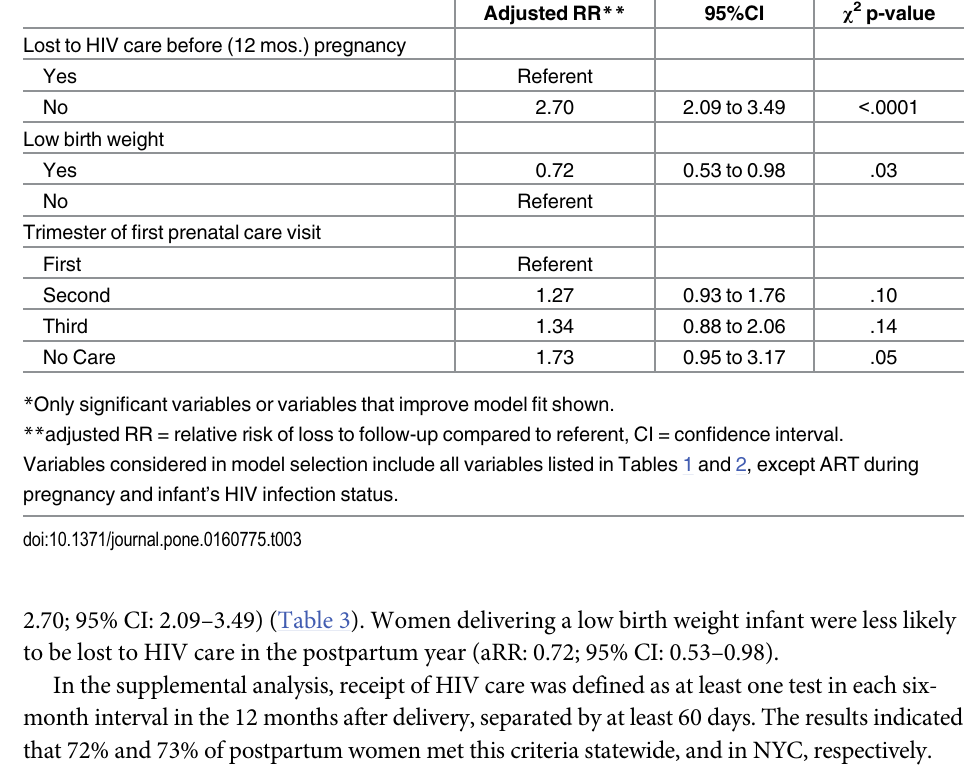
Table 3. Multivariable Predictors of Lost to HIV Care in the Postpartum Year among HIV-Infected Women with a Live Birth, Diagnosed Before Pregnancy * . Adjusted RR ** 95%CI χ 2 p-value Lost to HIV care before (12 mos.)